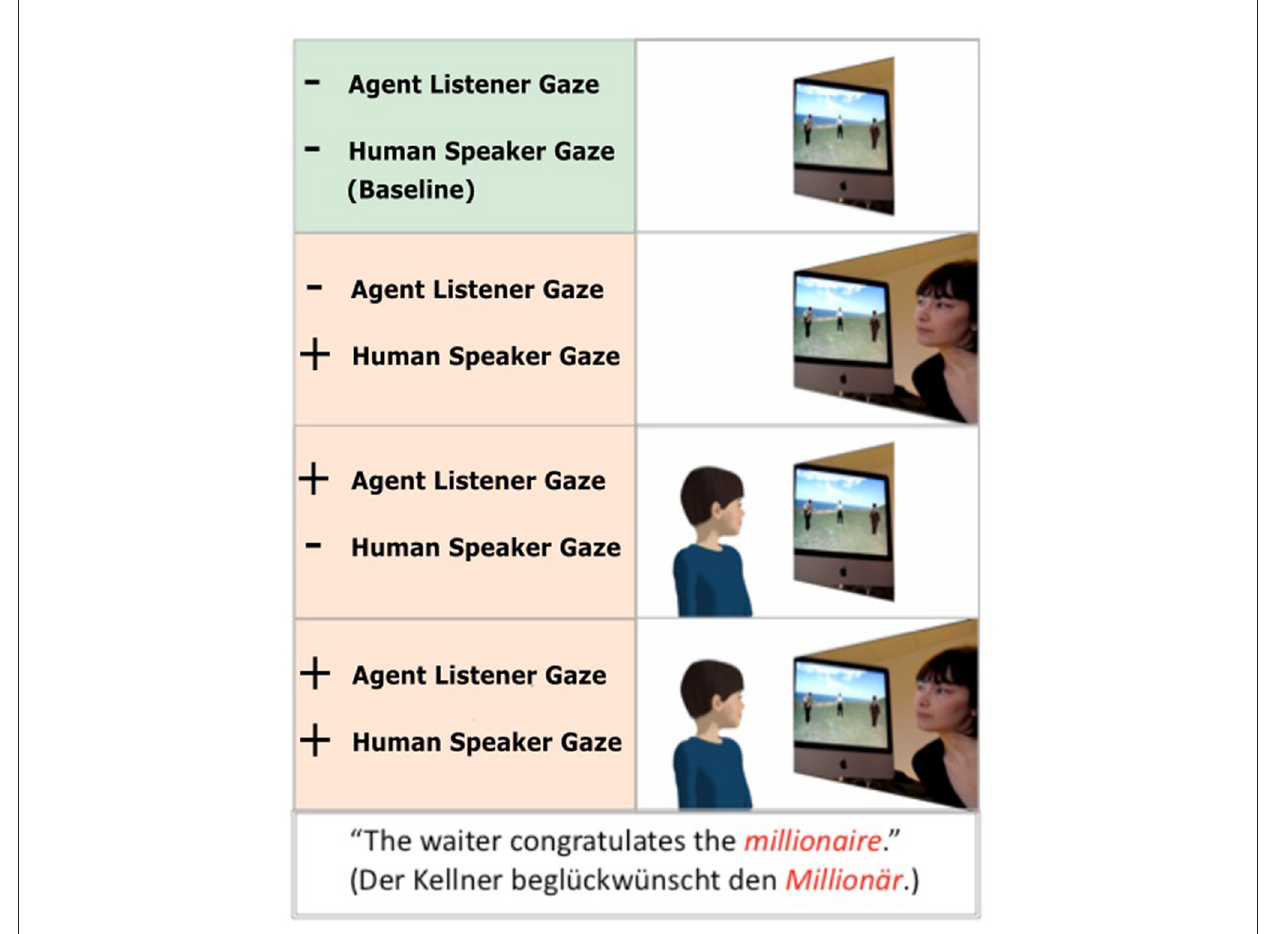
FIGURE3 Overview of the four conditions used in Experiments 1–4. Adapted from Nunnemann (2021, p. 69).